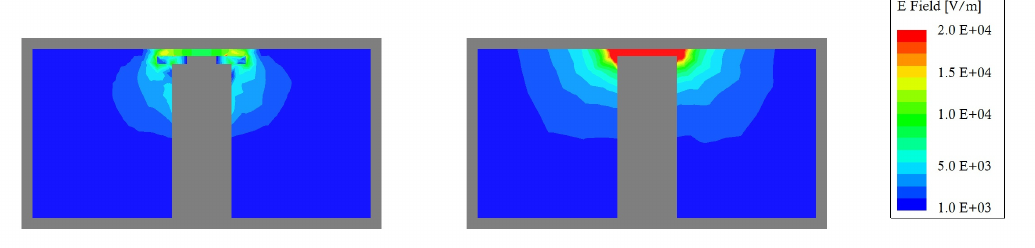
Figure 3. Field distribution in the end launcher step ( left ) and in the first ridge step ( right ). The metallic walls and the ridge are shown in grey.